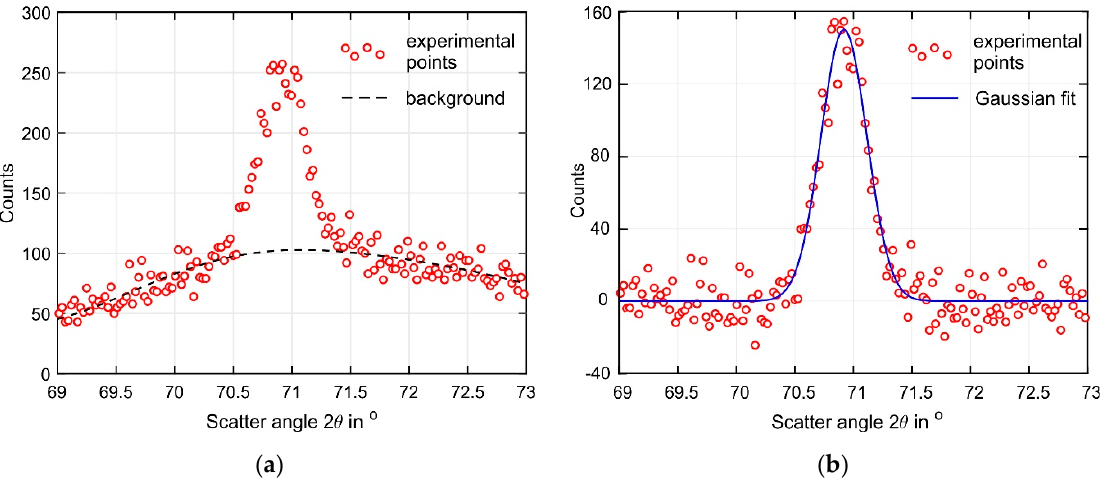
Figure 5. Example of experimental data processing ( a ) before and ( b ) after background